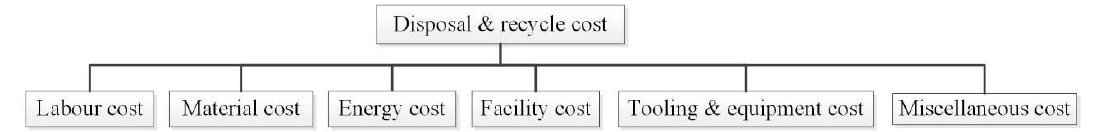
Figure 3. Disposal and recycle Cost Breakdown Structure (CBS).